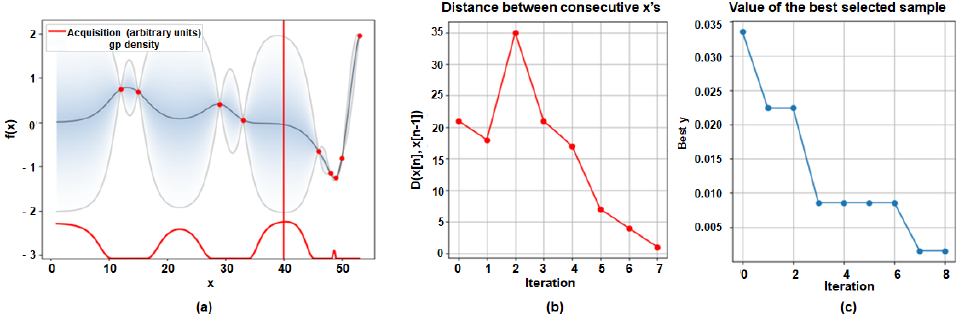
Figure 8. Visualization results of the optimal sharing layer configuration through BayesOpt BayesOpt as threshold accuracy degradation is 3% less than the baseline accuracy. (60 classes/40 classes) ( a ) The result of the selected optimal number of sharing layers. ( b ) The L2 distance of the consecutive observed points. ( c ) The value of the calculated best-selected sample for every